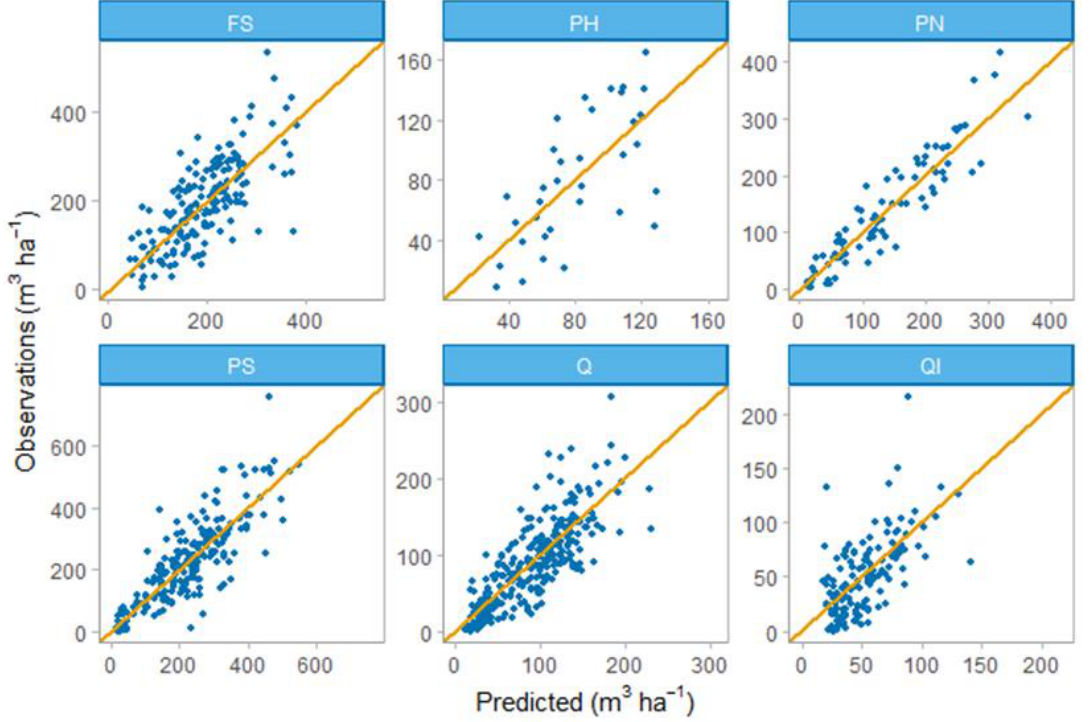
Figure 5. Volume reference values for each of the field plots, used to construct the different RF models, versus their predictions. Note: FS: Fagus sylvatica ; PH: Pinus halepensis ; PN: Pinus nigra ; PS: Pinus sylvestris ; Q: Quercus pyrenaica/faginea ; QI: Quercus ilex . Orange line represents the 1:1 line.